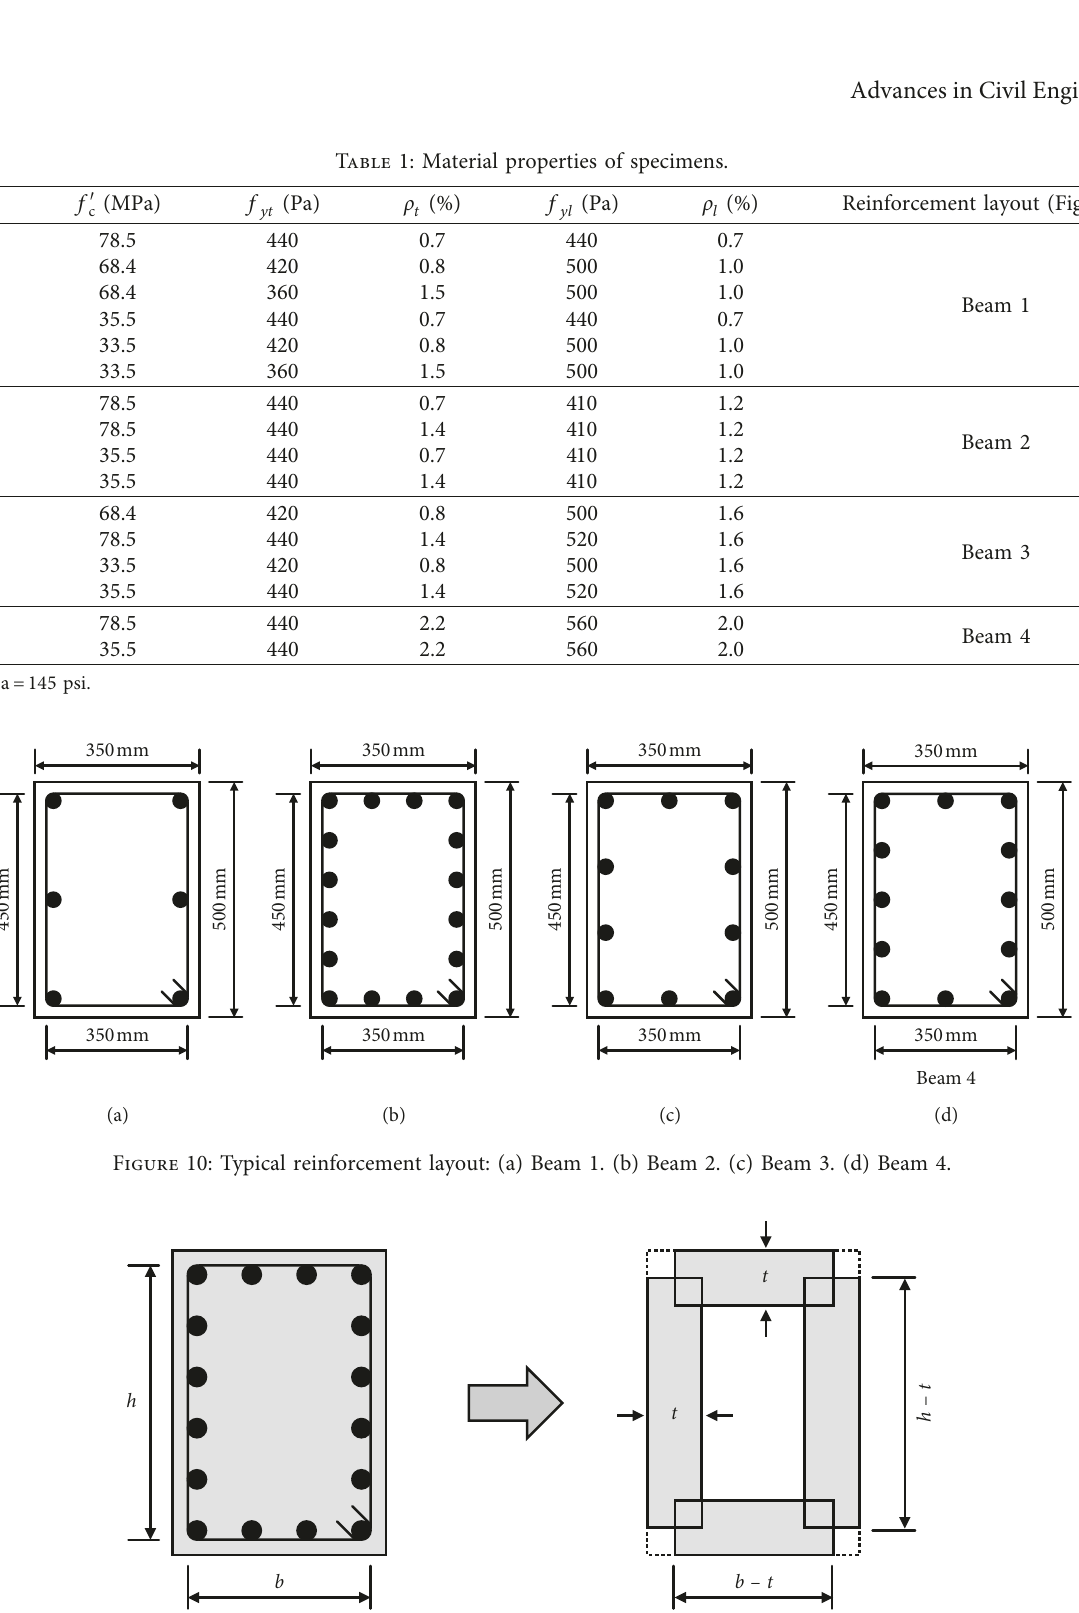
Figure 11: Idealization of a reinforced concrete beam for sectional analysis transforms a solid RC section into an equivalent thin-walled tube consisting of four side